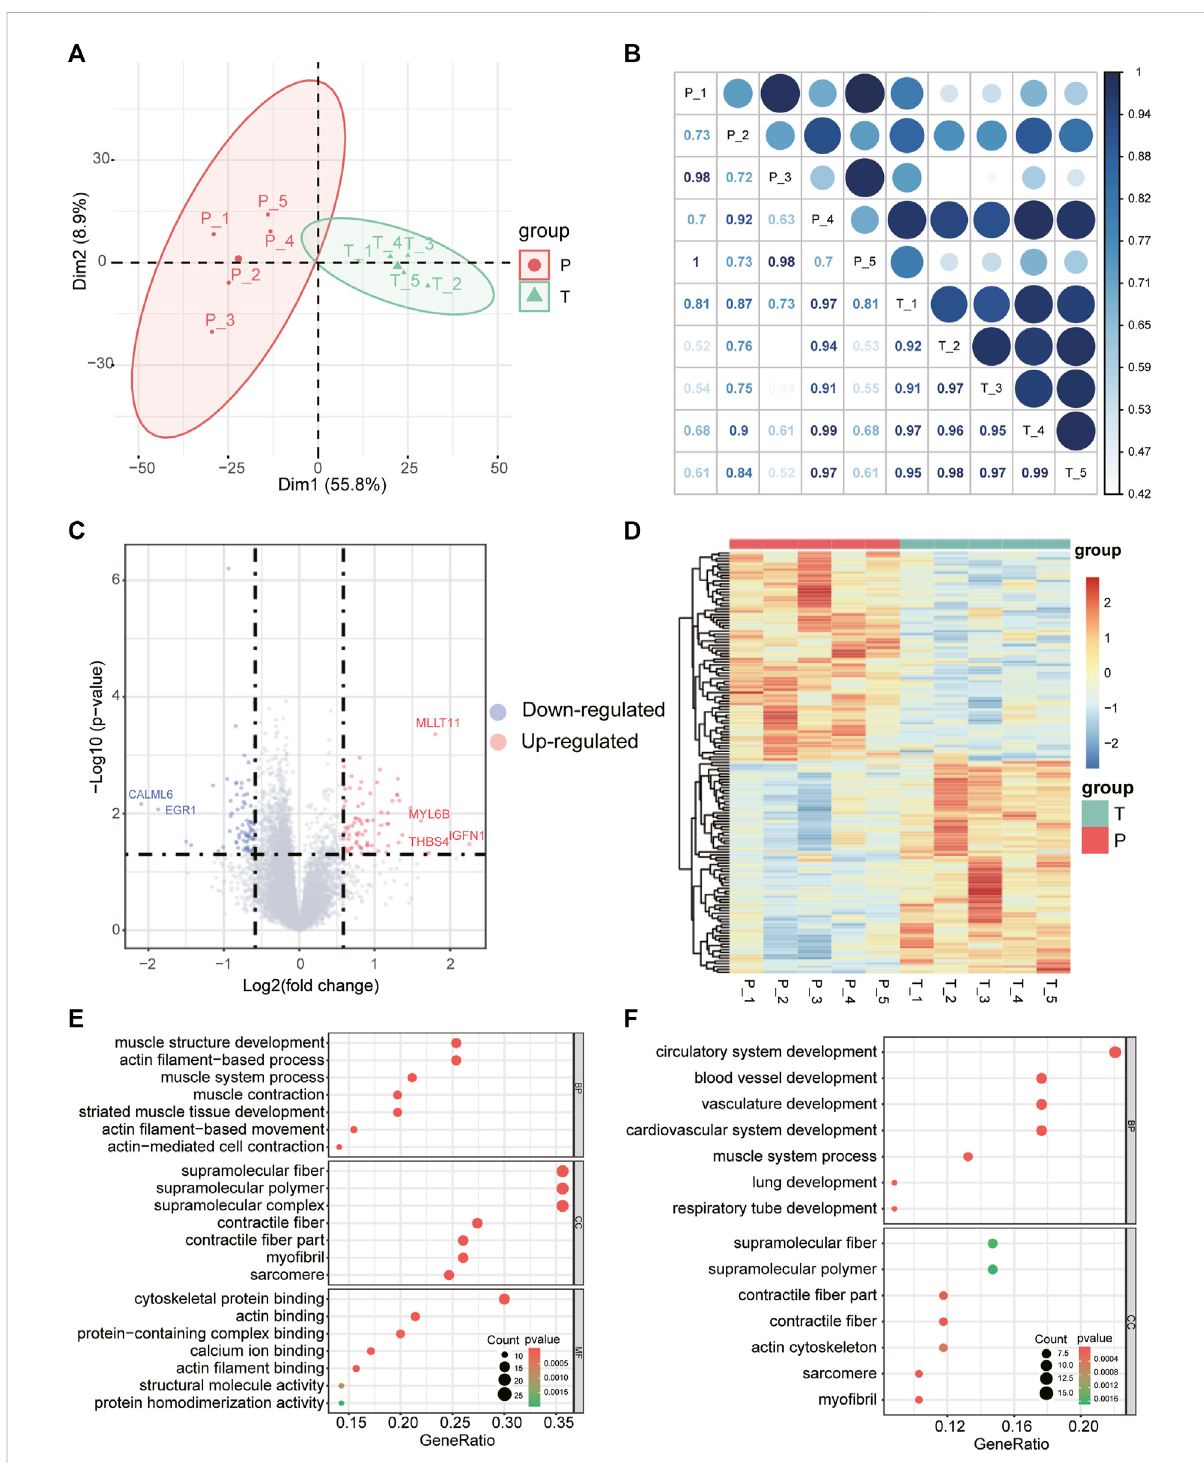
FIGURE 1 Differentially expressed mRNAs and GO enrichment analysis. (A) The fi rst two principal components show distinction between torn supraspinatus muscles and matched unharmed subscapularis muscles based on the mRNA expression pro fi le. (B) Heatmap of the correlation matrix of mRNA expression pro fi le of 10 samples, the size of the node represents the correlation coef fi cient. (C) Volcano plot of differentially expressed mRNAs in RCT. Red points denote up-regulated mRNAs, and blue points denote down-regulated mRNAs. The most up- or down-regulated mRNAs are labeled. (D) Heatmap depicting expression levels of the differentially expressed mRNAs in RCT. (E,F) GO enrichment analysis for the up- regulated (E) and down-regulated differentially expressed mRNAs (F) ,